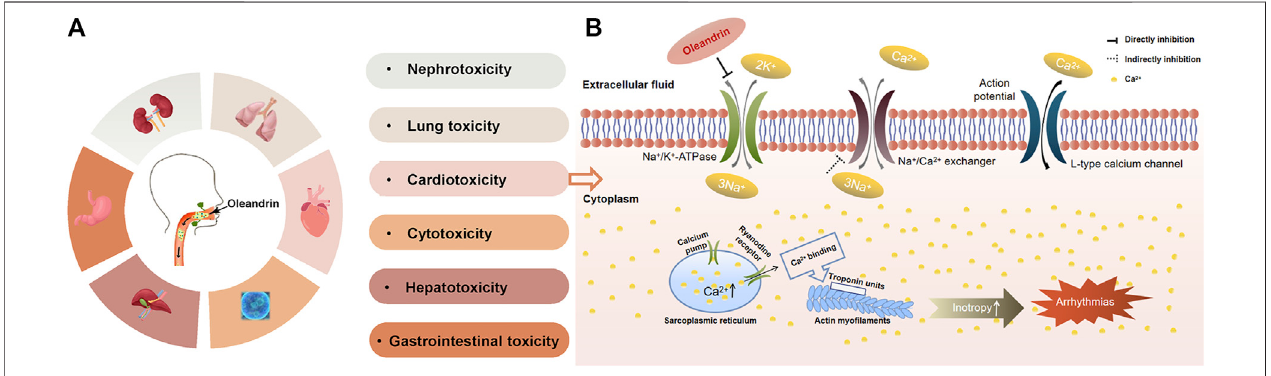
FIGURE 5 | The toxicity of oleandrin and its typical toxicity mechanism. (A) Summary of the toxicity of oleandrin. (B) Schematic representation of oleandrin- mediated inhibition of Na/K-ATPase in cardiac myocytes.